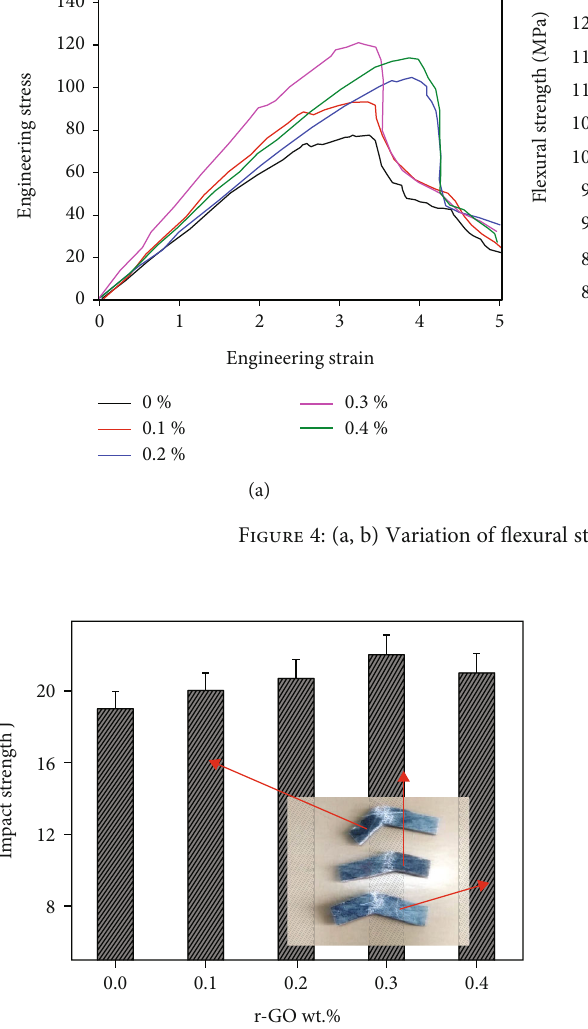
Figure 5: Variation of impact strength with respect to r-GO